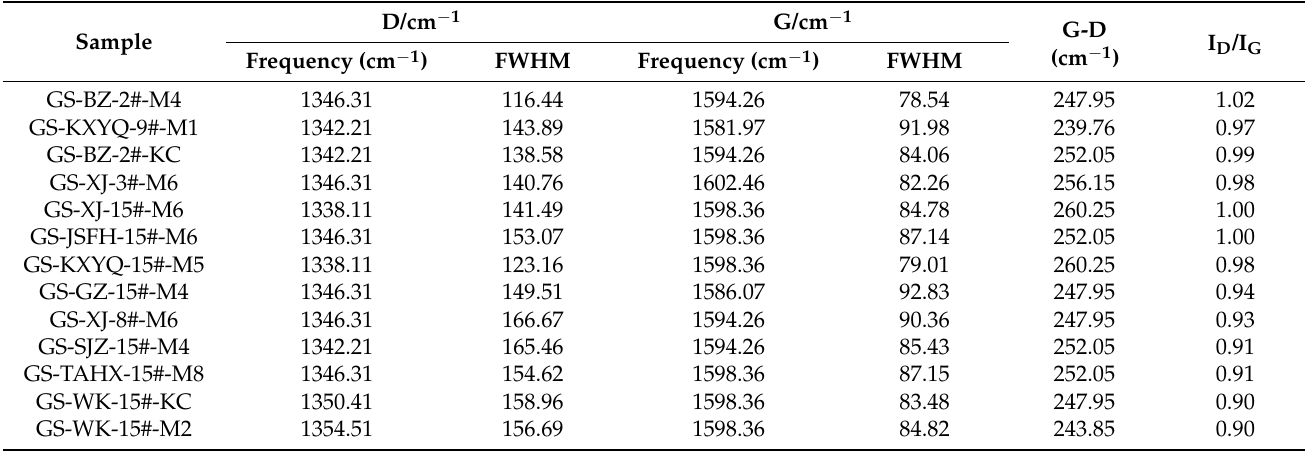
Figure 12. Raman patterns of coal-based graphene. Table 8. Raman parameters of coal-based graphene.